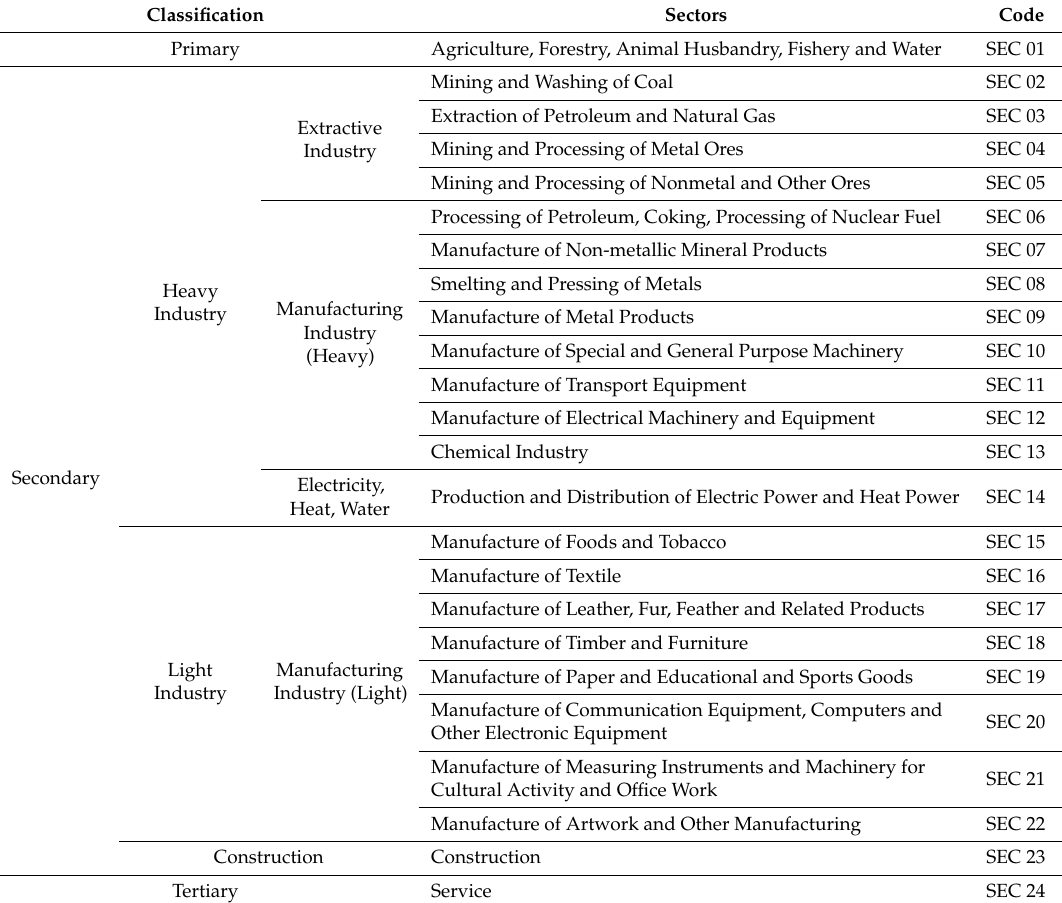
Table 1. The classifications of sectors and